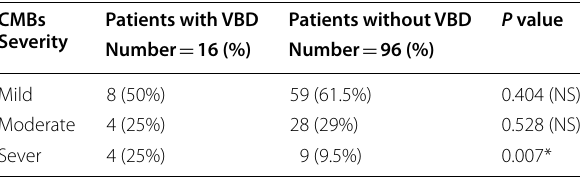
Table 3 Stroke subtypes among ischemic stroke patients Stroke subtypes